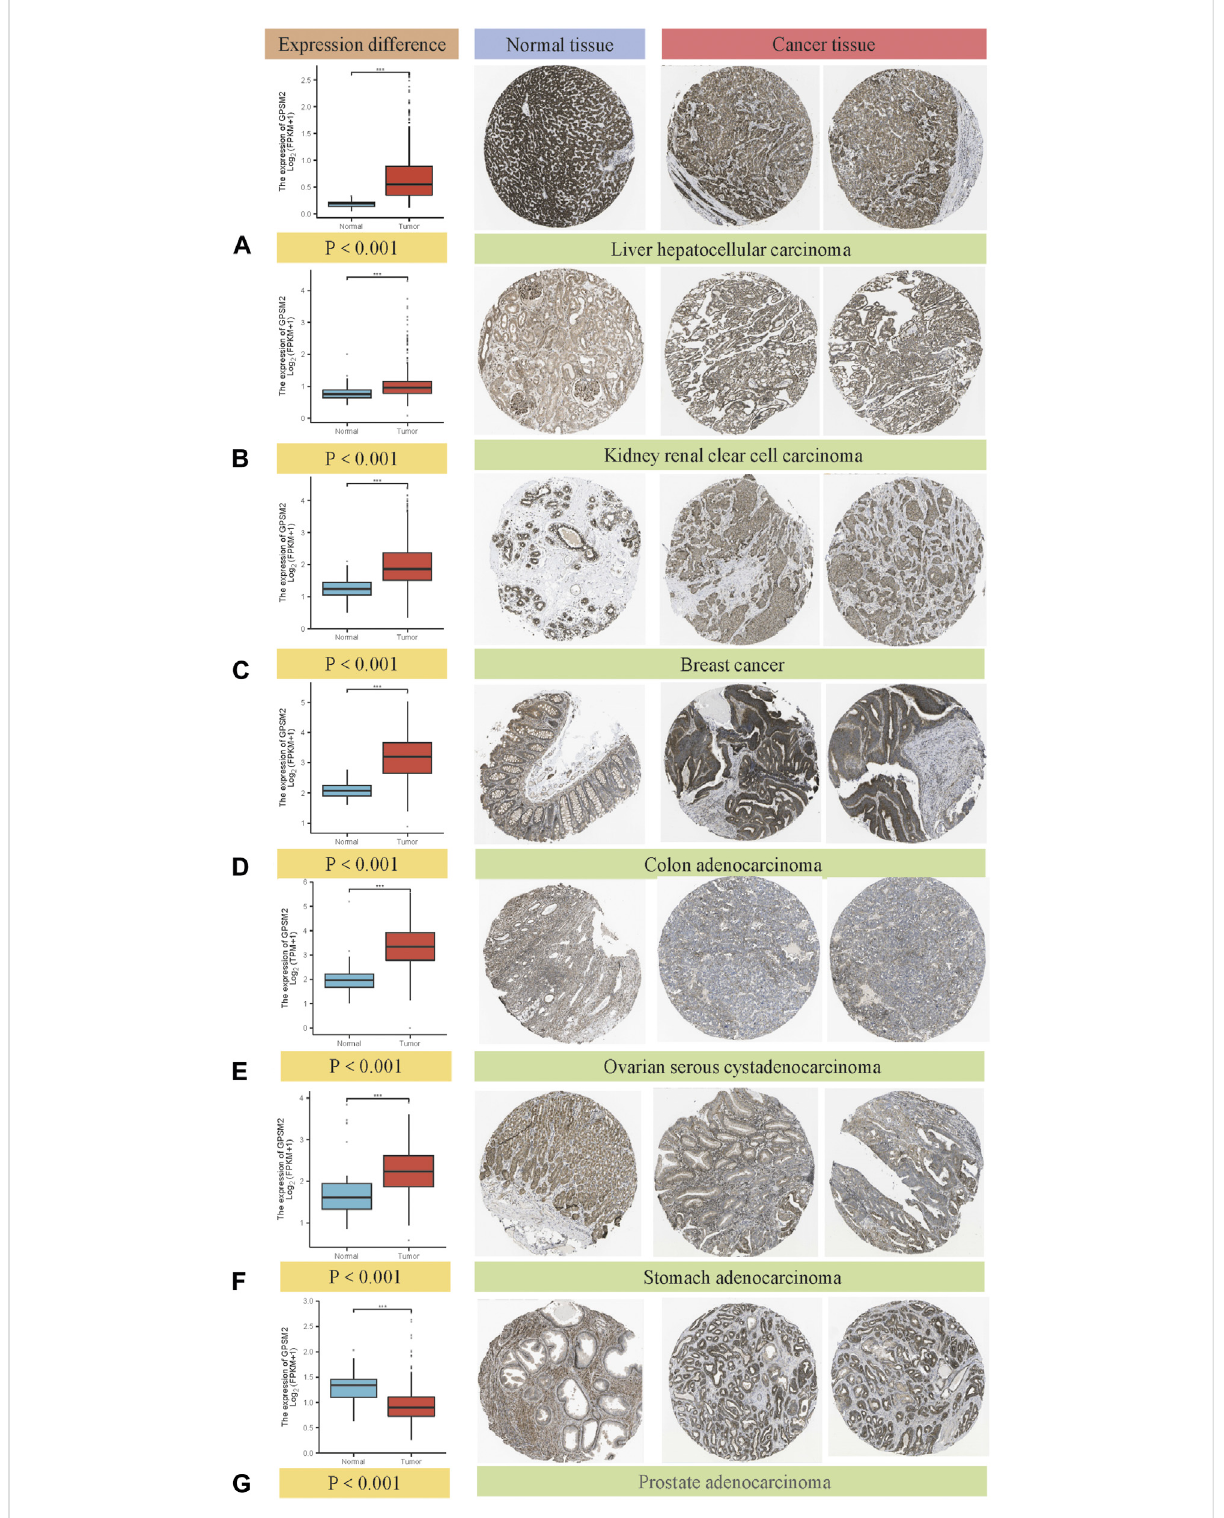
FIGURE 2 Box diagram of GPSM2 expression between normal and tumor tissues (left), comparison of immunohistochemical staining between normal (middle) and tumor tissues (right). GPSM2 expression in (A) LIHC, (B) KIRC, (C) BRCA, (D) COAD, (E) OV and (F) STAD was signi fi cantly increased, and the expression in (G) PRAD was lower than that in normal